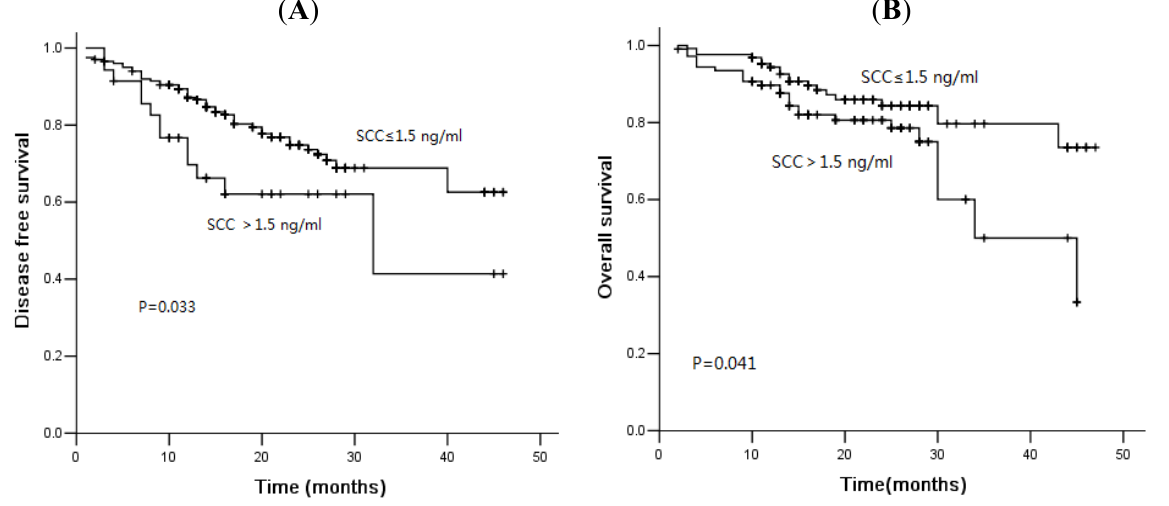
Figure 4. Kaplan-Meier disease-free survival curves ( A ) and overall survival curves ( B ) according to SCC in squamous cell lung cancer: patients with high levels of SCC showed shorter overall survival.